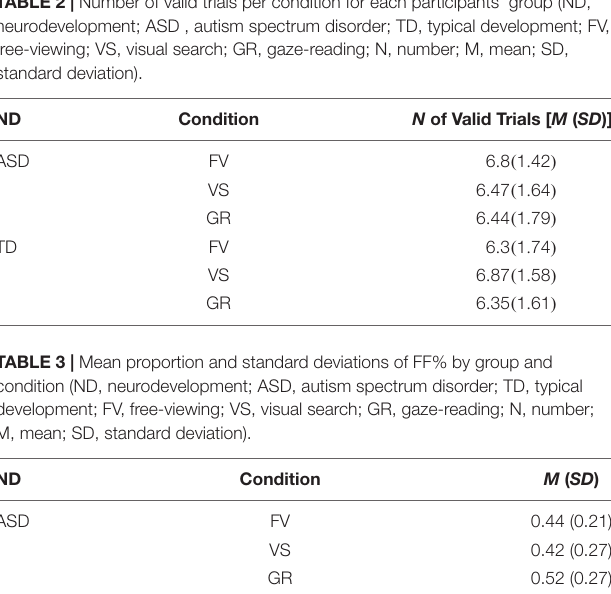
TABLE 5 | Mean FD and standard deviations in seconds on face and body by group and condition (ND, neurodevelopment; ASD, autism spectrum disorder; TD,